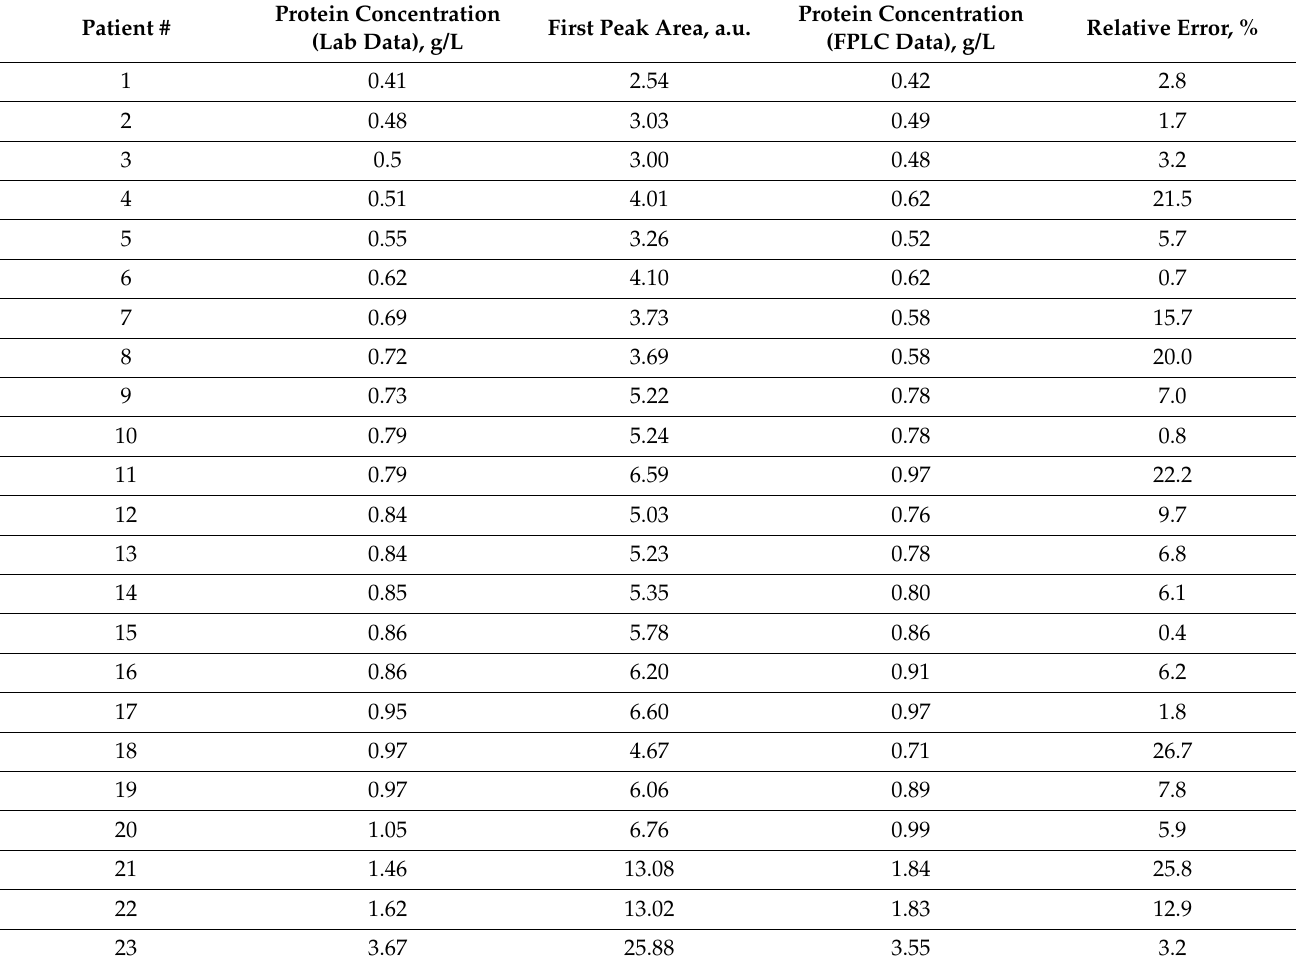
Table 1. Comparison of laboratory data with FPLC